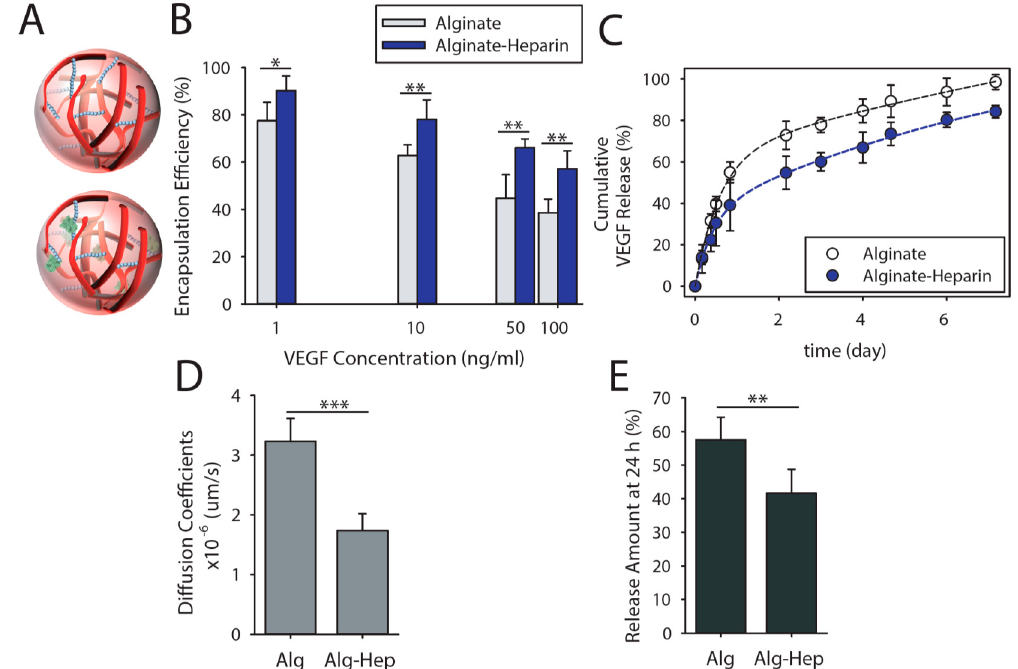
Figure 2. The presence of heparin increased vascular endothelial growth factor (VEGF) binding and prolongs its release. ( A ) Schematic of microparticles (16 µm in diameter) were used to encapsulate therapeutic proteins (here VEGF). ( B ) VEGF binding efficiency of alginate and alginate-heparin microparticles at various initial concentrations of VEGF after 16 h incubation at 4 °C. ( C ) VEGF release kinetic of microfluidic-synthesized microparticles prepared from alginate and alginate-heparin in phosphate buffered saline (PBS) at 37 °C. ( D ) Calculated diffusion coefficients of VEGF from microparticles and ( E ) the cumulative amount of released VEGF after 24 h. The presented data are expressed as an average ± SD; number of independent experiments, n = 3; number of samples per experiment, s = 5). The lines in the graphs are guide for the eye. *, **, and *** indicate significant difference of p < 0.05, p < 0.01, and p < 0.001, respectively, as evaluated by one-way ANOVA.